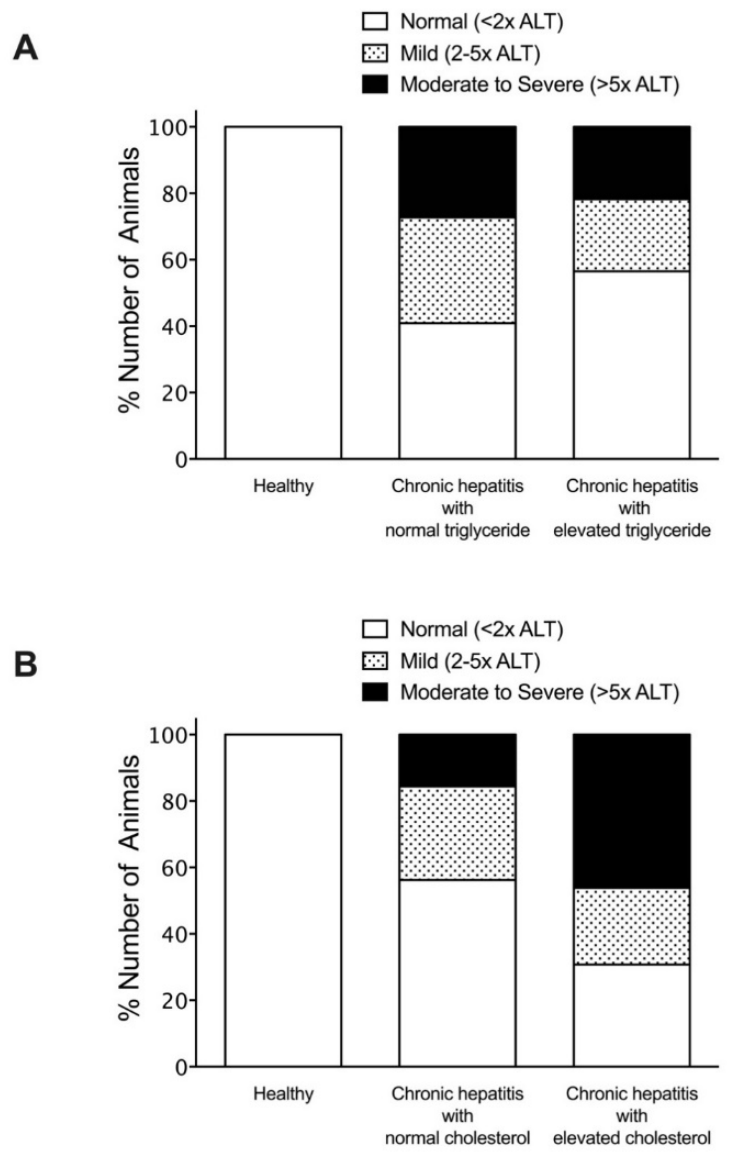
Figure 2. Histogram illustrating serum ALT concentrations of healthy dogs and dogs with chronic hepatitis, classified by triglyceride levels ( A ) or cholesterol levels ( B ). The magnitude of serum ALT concentration was divided into normal, mild, and moderate to